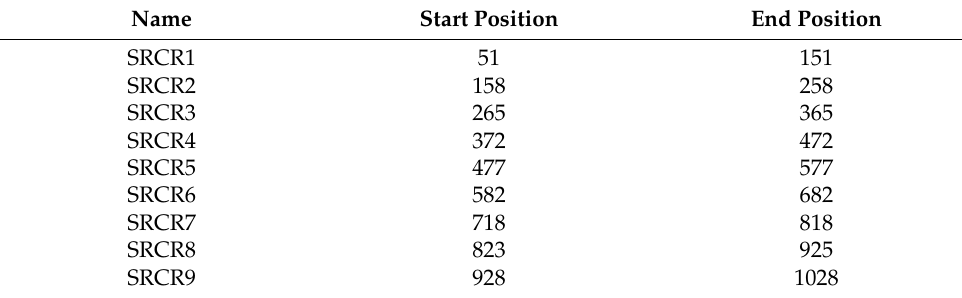
Table 2. The SRCR domains of porcine CD163